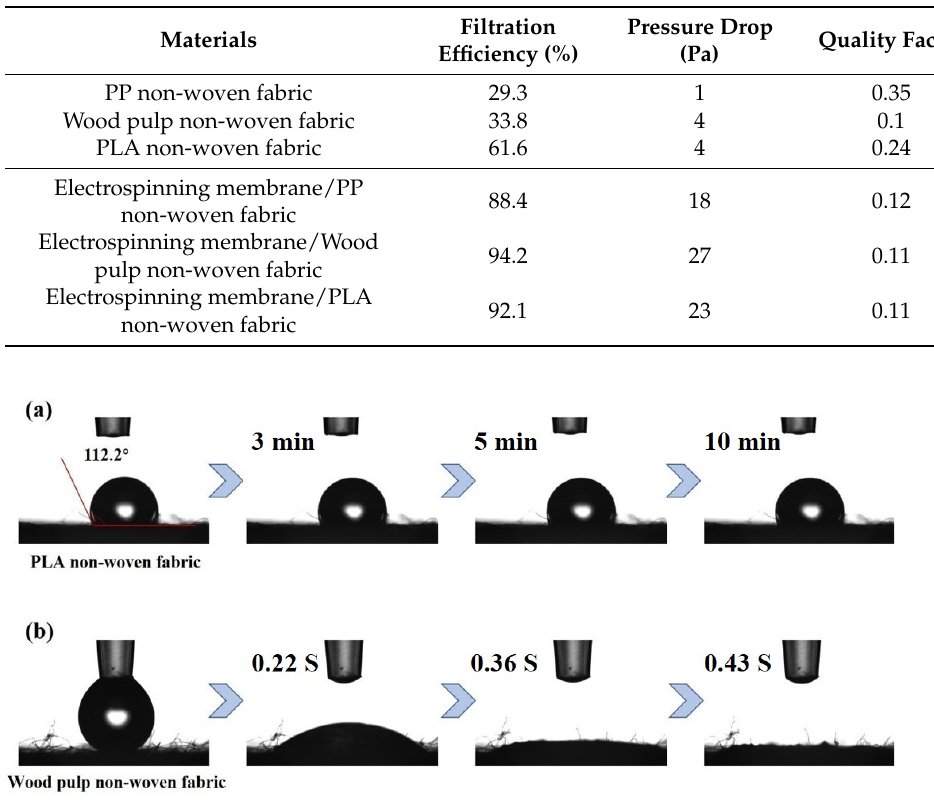
Table 2. Effect of non-woven fabric and electrospinning membrane on filtration efficiency.